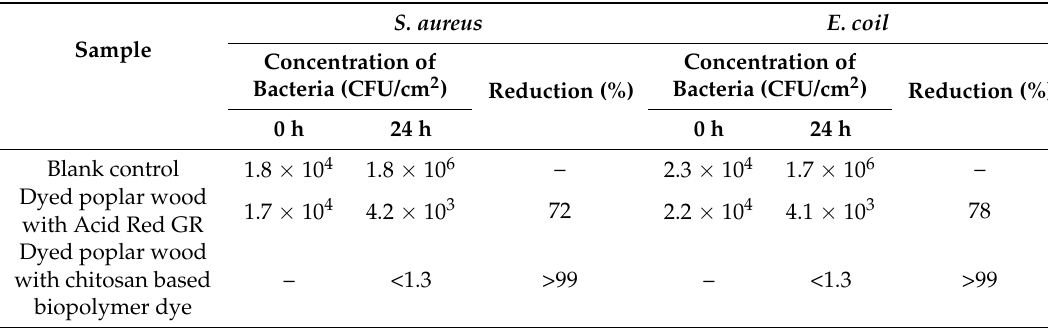
Table 2. Antibacterial activity of chitosan-based biopolymer dye.